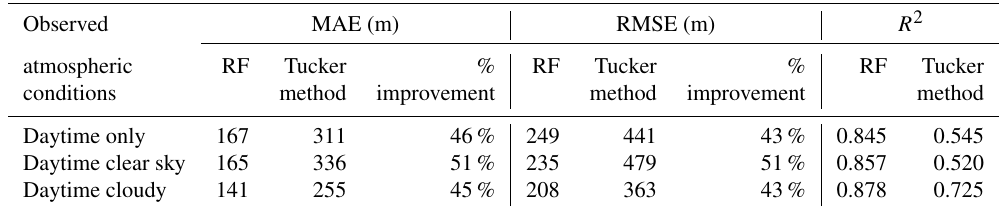
Table 3. Systematic mean absolute errors, root-mean-square error, and correlation coefficient ( R 2 ) between RF, Tucker method, and ra- diosonde z i estimates in 2019. Observed MAE (m) RMSE (m) R 2 atmospheric RF Tucker % RF Tucker % RF Tucker conditions method improvement method improvement method Daytime only 167 311 46% 249 441 43% 0.845 0.545 Daytime clear sky 165 336 51% 235 479 51% 0.857 0.520 Daytime cloudy 141 255 45% 208 363 43% 0.878